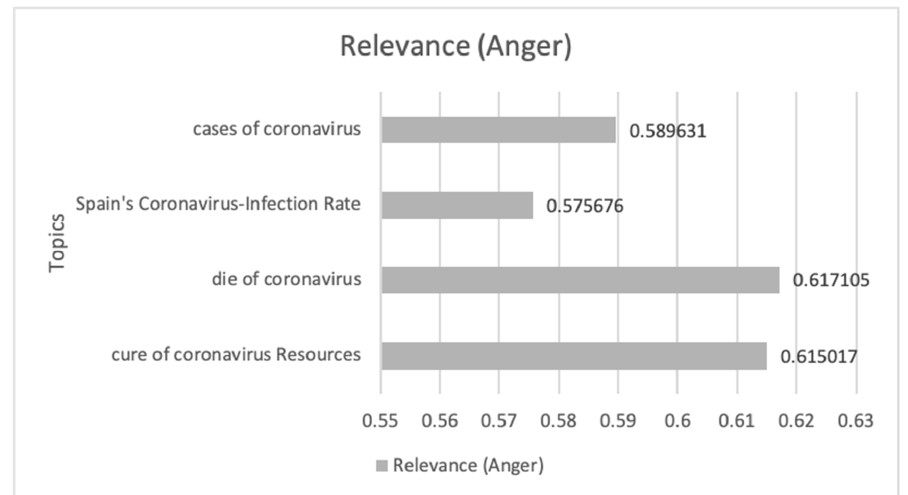
Figure 9. The themes related to COVID-19 and Fear Emotion that have impacted most along with its impact